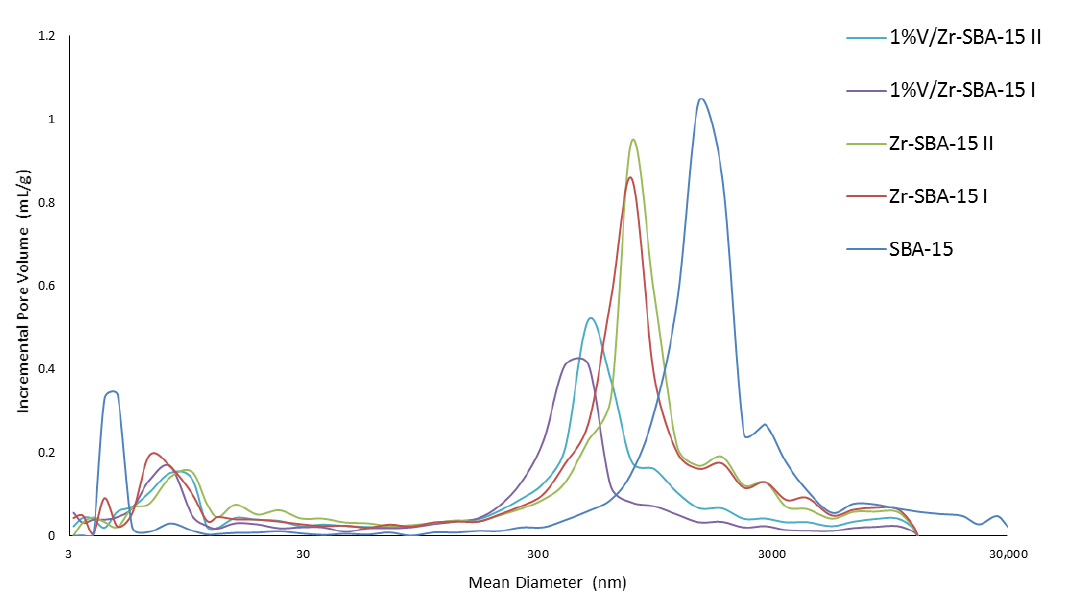
Figure 1. Mercury porosimetry analyses. Pore diameter and pore volume with a given diameter for the fresh catalysts.